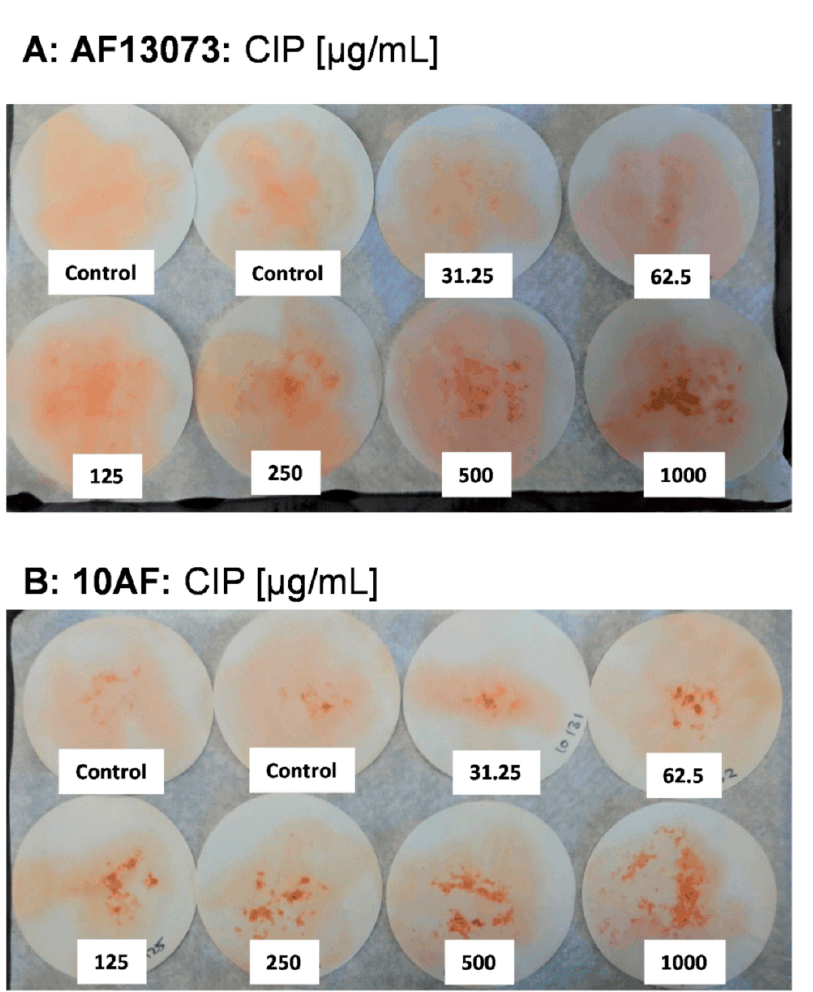
Figure 3. CIP induces planktonic growth of A. fumigatus wildtype strains AF13073 ( A ) and 10AF ( B ). After 48 h of planktonic growth in the presence of CIP (final concentrations 31.25–1000 µ g/mL in RPMI 1640 medium), tubes were diluted 1:2 with XTT solution, incubated at 37 ◦ C for 30 min, and the complete content of each tube was spread on filter